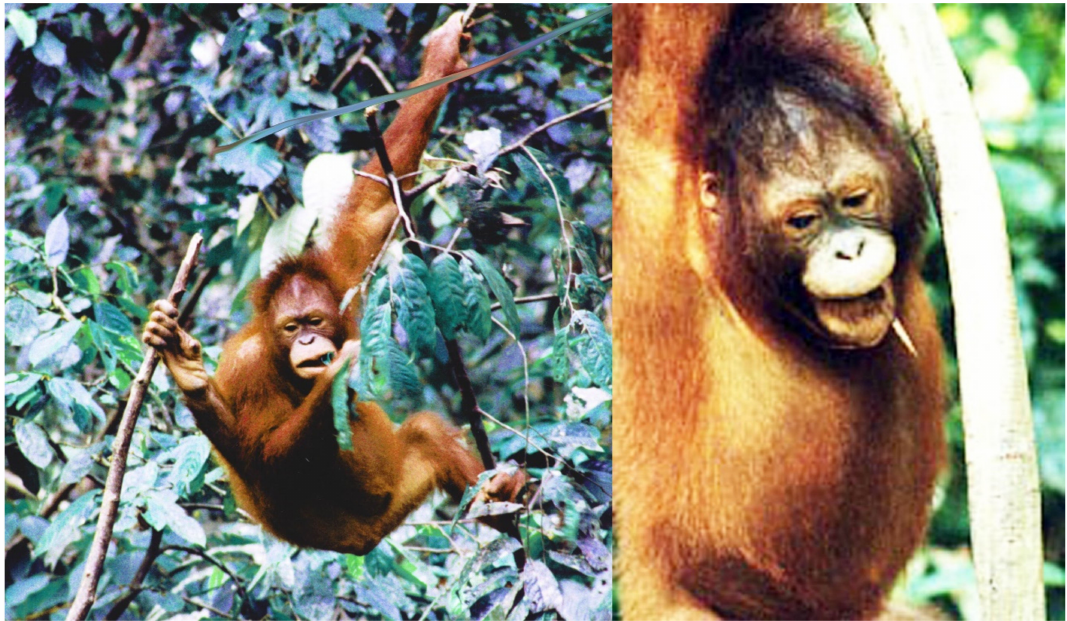
Figure 1. ( Left ): The nine-year-old Abbie is showing o ff , swinging in front of us- a special “performance”–amongst vines that are di ffi cult to negotiate. Note her foot, more like a hand, which can be used to push herself in the opposite direction or to pull herself forward to the next vine. ( Right ): Abbie dangling, showing her playface (upper lip tightly drawn over teeth) (Credits: G.